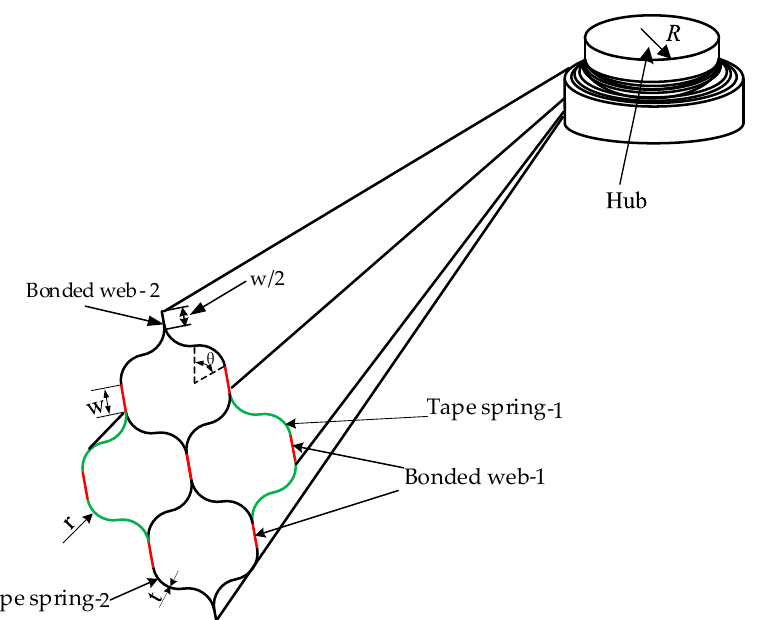
Figure 2. Geometric dimensions of the cross-section of the FLHD boom. The FLHD boom coiling mechanism is simplified to 15 parts, as shown in Figure 3. Two radial rollers are symmetrically positioned on both sides of the FLHD boom, and 11 circumferential rollers are evenly distributed around a hub. The radius R of the hub is 125 mm, and the radial and circumferential rollers guide the FLHD boom to coil smoothly around the hub. The axial distance between reference point (RP) 13 and RP14 is 78 mm, and the radial distance between the outer arc of the circumferential roller and the edge of the hub is 25 mm. The longitudinal length ( L ) and t of the FLHD boom are set to 2000 mm and 0.18 mm, respectively; the stacking sequence of the composite material is [45°/ − 45°/ − 45/°45°], as shown in Figure 4, and the thickness of each ply is t p = 0.045 mm. The ply material is T800; it is a strategic new material with low density, good rigidity, and high composite strength, which plays an irreplaceable role in aerospace and other fields. The material properties of T800 are listed in Table 1.